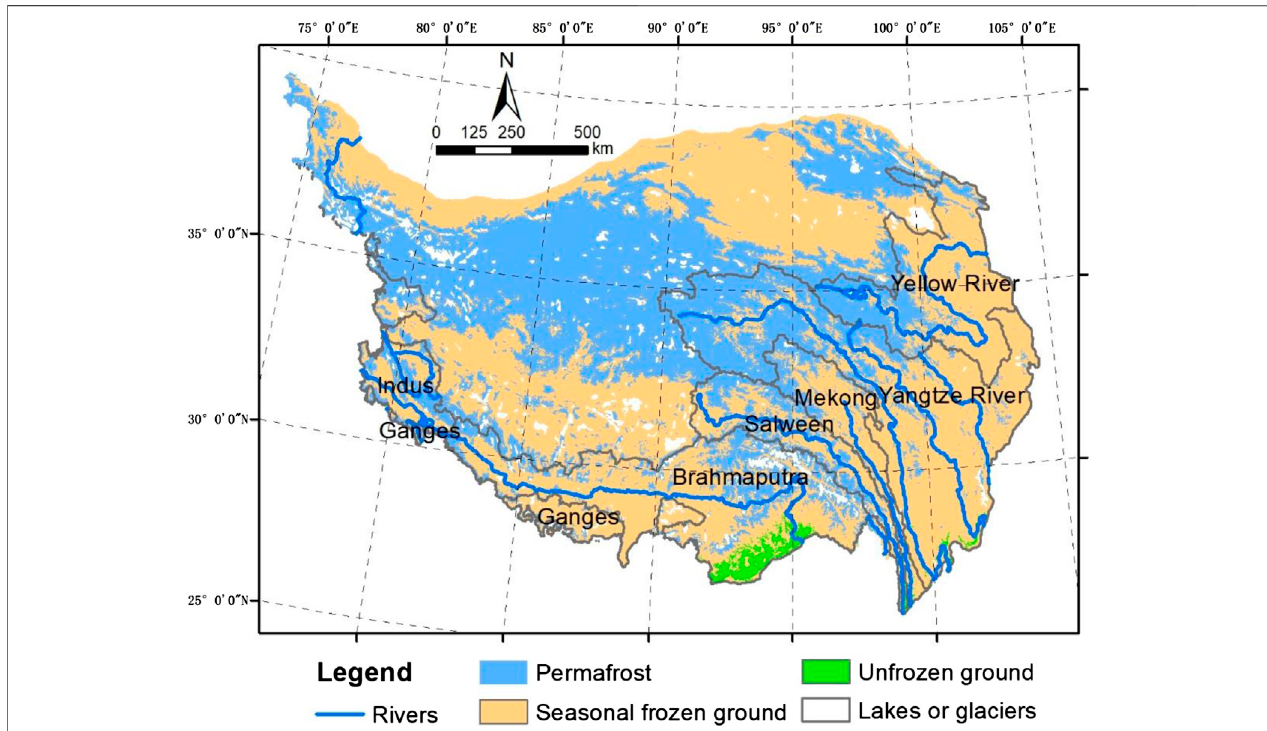
FIGURE 1 | Permafrost distribution map of the Qinghai-Tibet Plateau. The permafrost map was adapted from Zou et al. (2017), and the rivers and river basin boundary maps were obtained from the Global Runoff Data Centre (GRDC; data source: https://www.bafg.de/GRDC/EN/Home/homepage_node.html).